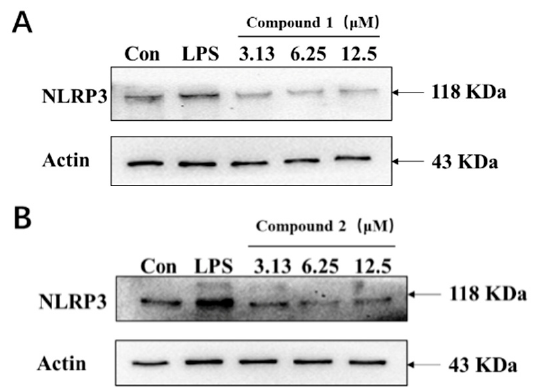
Figure 11. Inhibitory effects of compounds 1 and 2 on the NLRP3 expression in vitro. ( A ) The expression of NLRP3 after treatment with three doses of compound 1 . ( B ) The expression of NLRP3 after treatment with three doses of compound 2 .